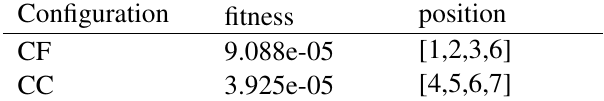
Fig. 3 Optimal distribution for both CC and CF boundary conditions for each generation. Table 2 Optimal configuration of the piezoelectric actuators